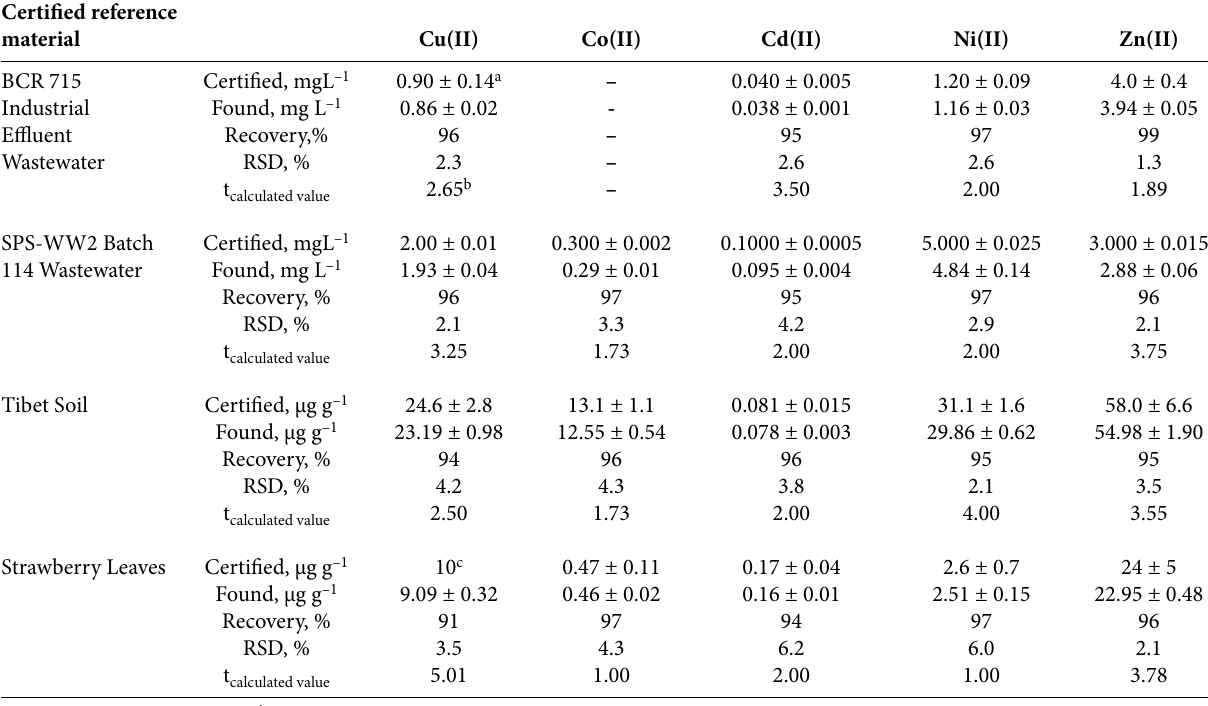
Table 5. Analysis of certified reference materials using present method (n =